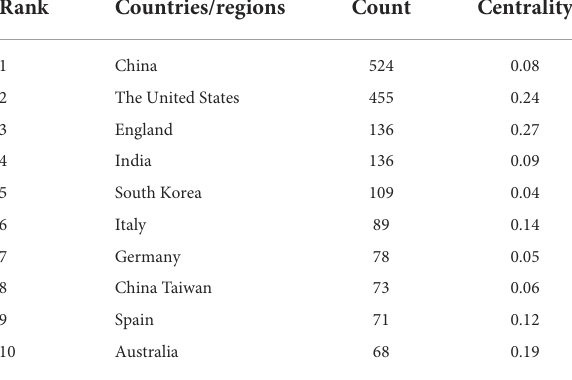
TABLE 1 The top 10 countries/regions publishing research on artificial intelligence and air pollution. Rank Countries/regions